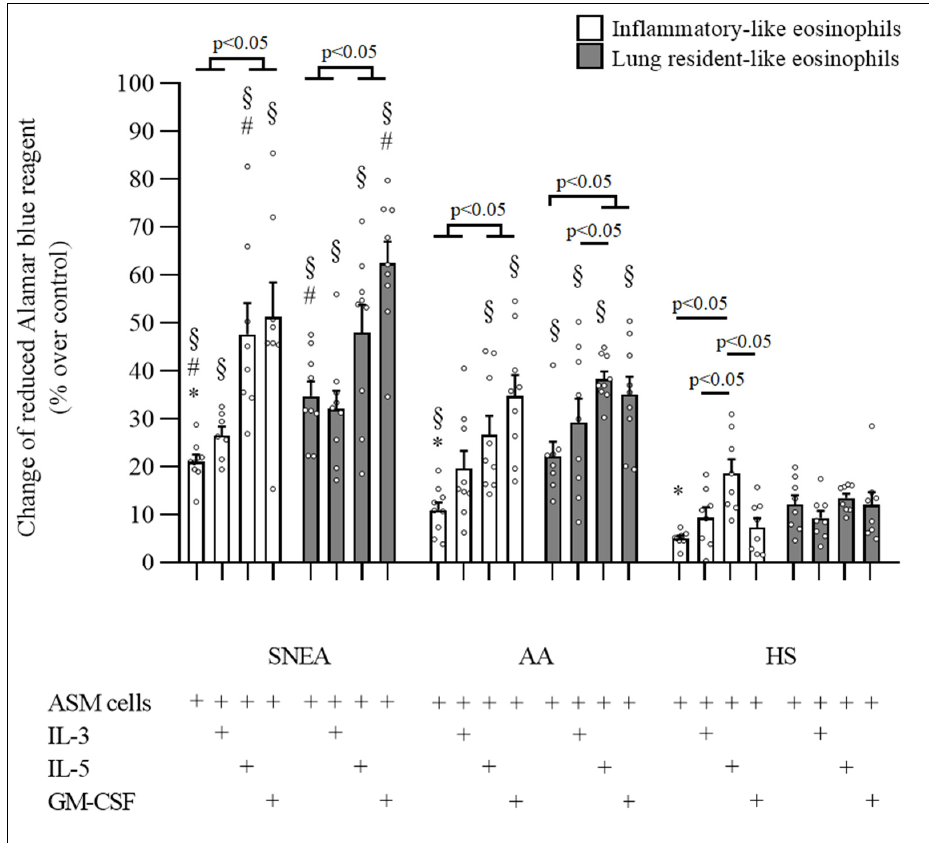
Figure 2. Effect of eosinophilopoetins on proliferative properties of blood eosinophil subtypes. ASM—airway smooth muscle; IL—interleukin; GM-CSF—granulocyte-macrophage colony-stimulating factor. Severe nonallergic eosinophilic asthma (SNEA) group n = 10, nonsevere allergic asthma (AA) group n = 9, healthy subjects (HS) group n = 8. Data presented as the mean ± standard error of the mean. * p < 0.05 compared with appropriate rEOS-like cells in the same group. # p < 0.05 compared with appropriate eosinophil subtypes from AA group. § p < 0.005 compared with appro- priate eosinophil subtypes from HS group. Statistical analysis: between investigated groups, Mann–Whitney two-sided U-test; within one study group, Wilcoxon matched-pair signed-rank two-sided test. Data presented as the mean ± standard error of the mean.